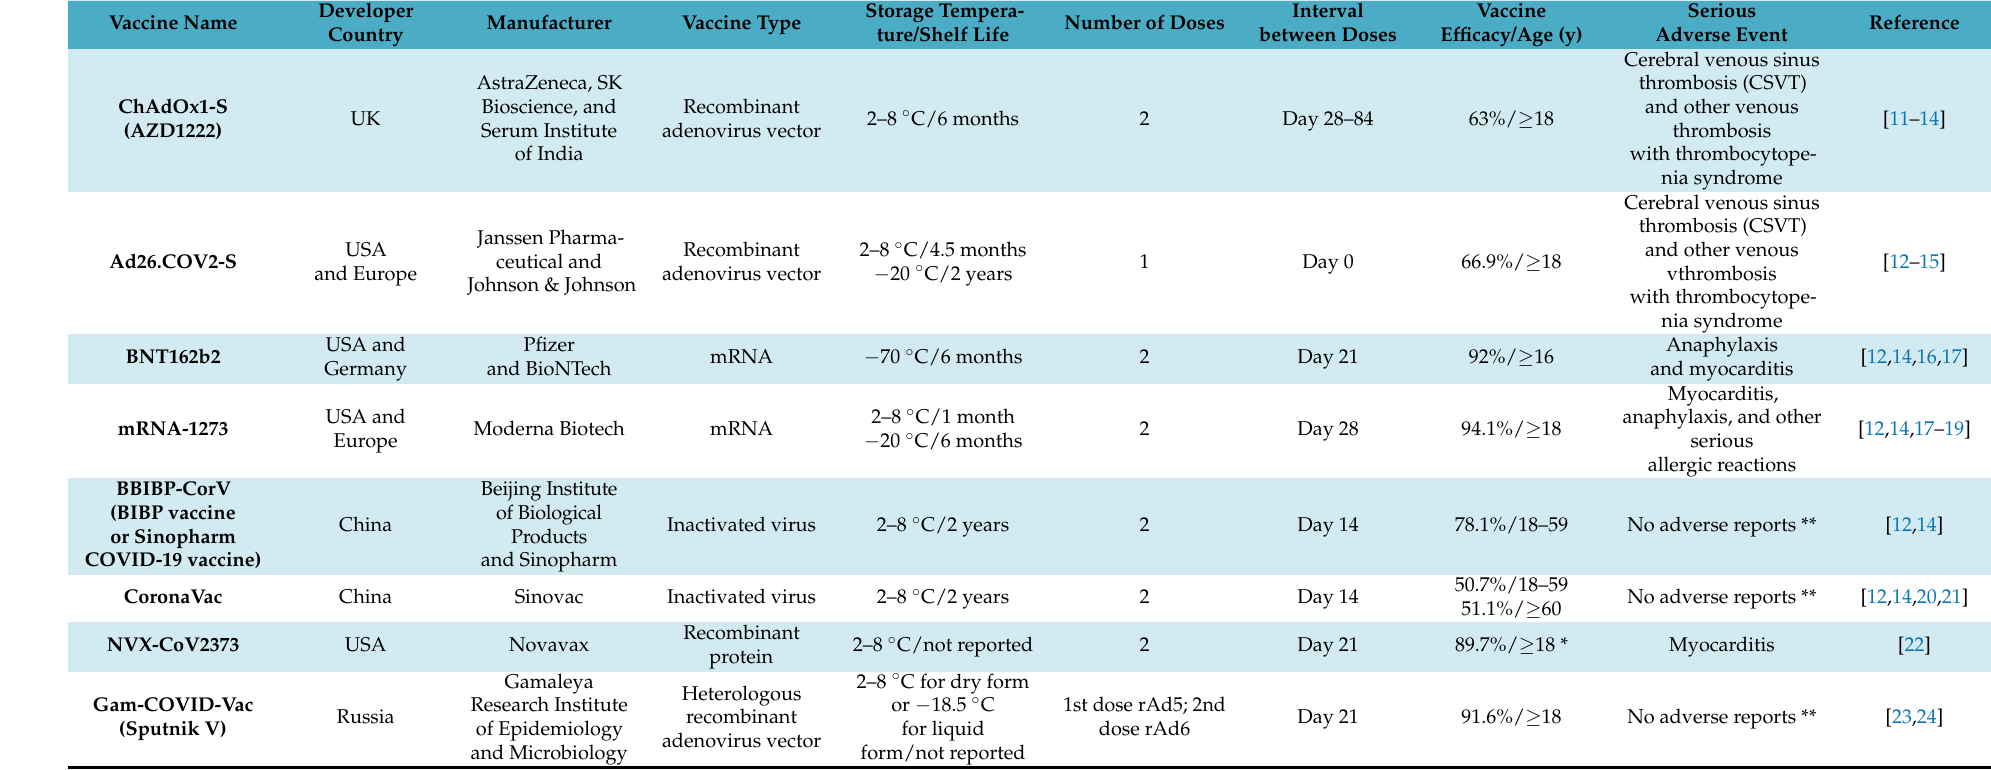
Table 1. List of valid vaccines for